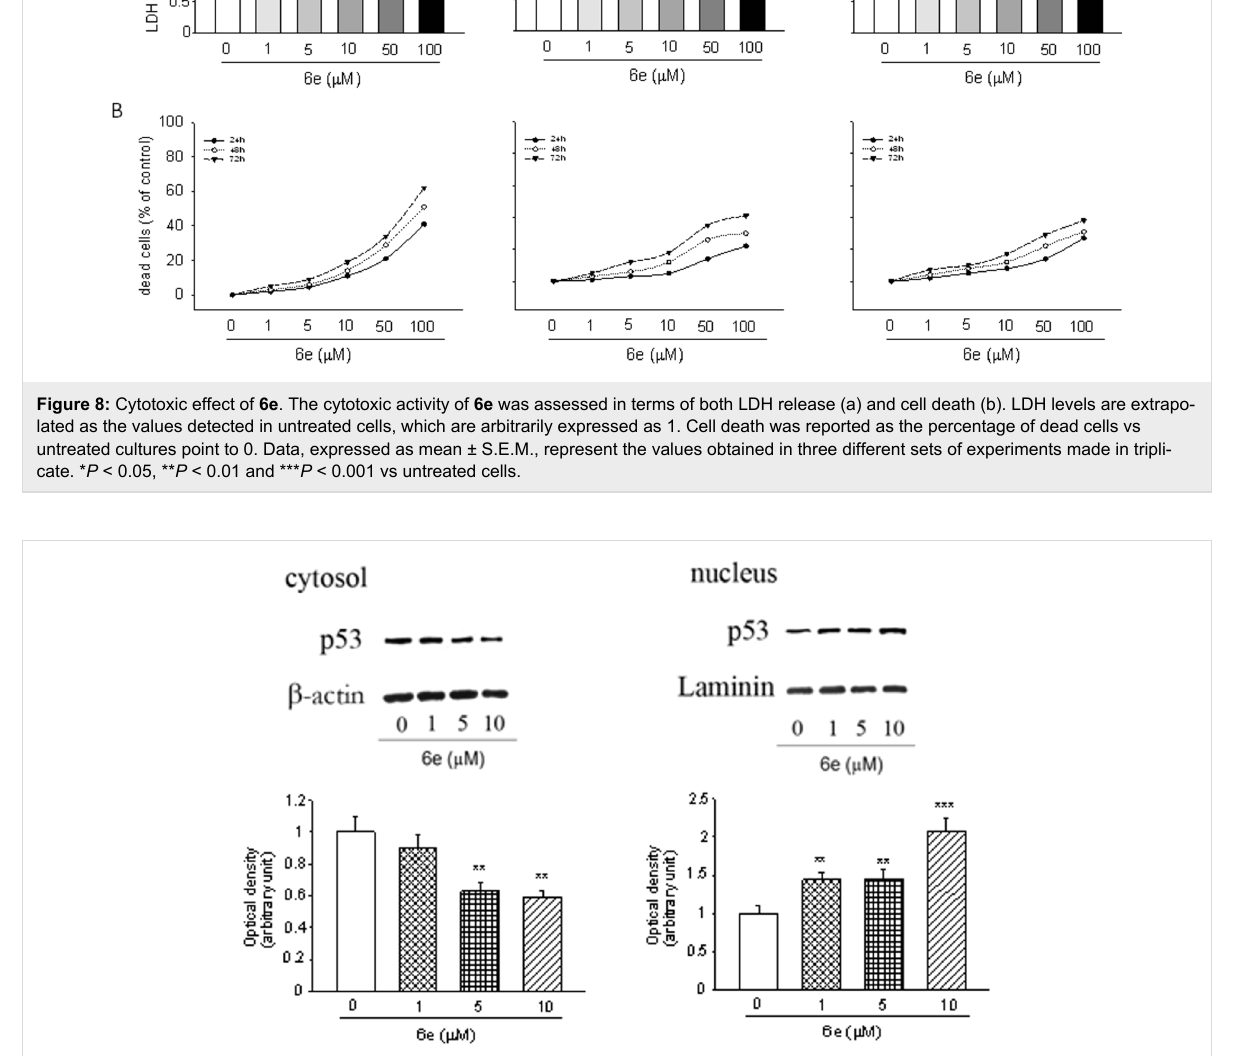
P < 0.001 vs untreated cells), demonstrating its involvement in the anti-cancer effect elicited by 6e